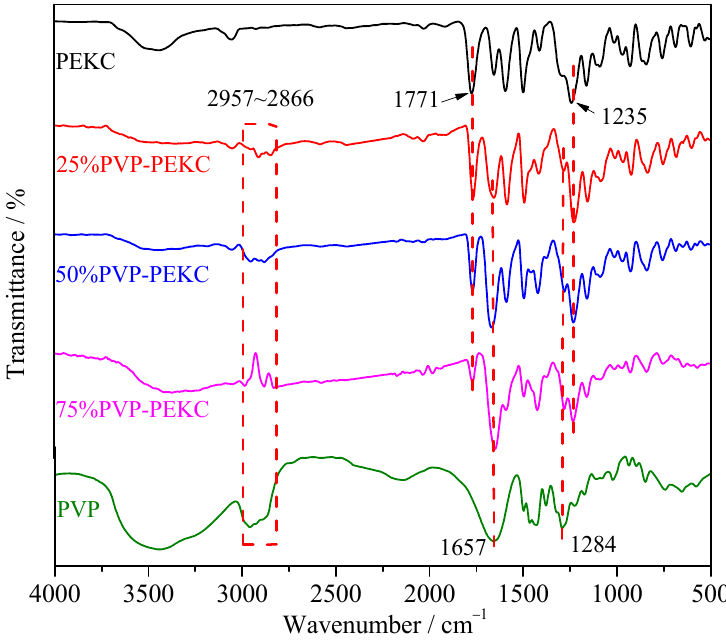
Figure 3. FT-IR spectra of PEKC, PVP and various blended x%PVP-PEKC membranes.